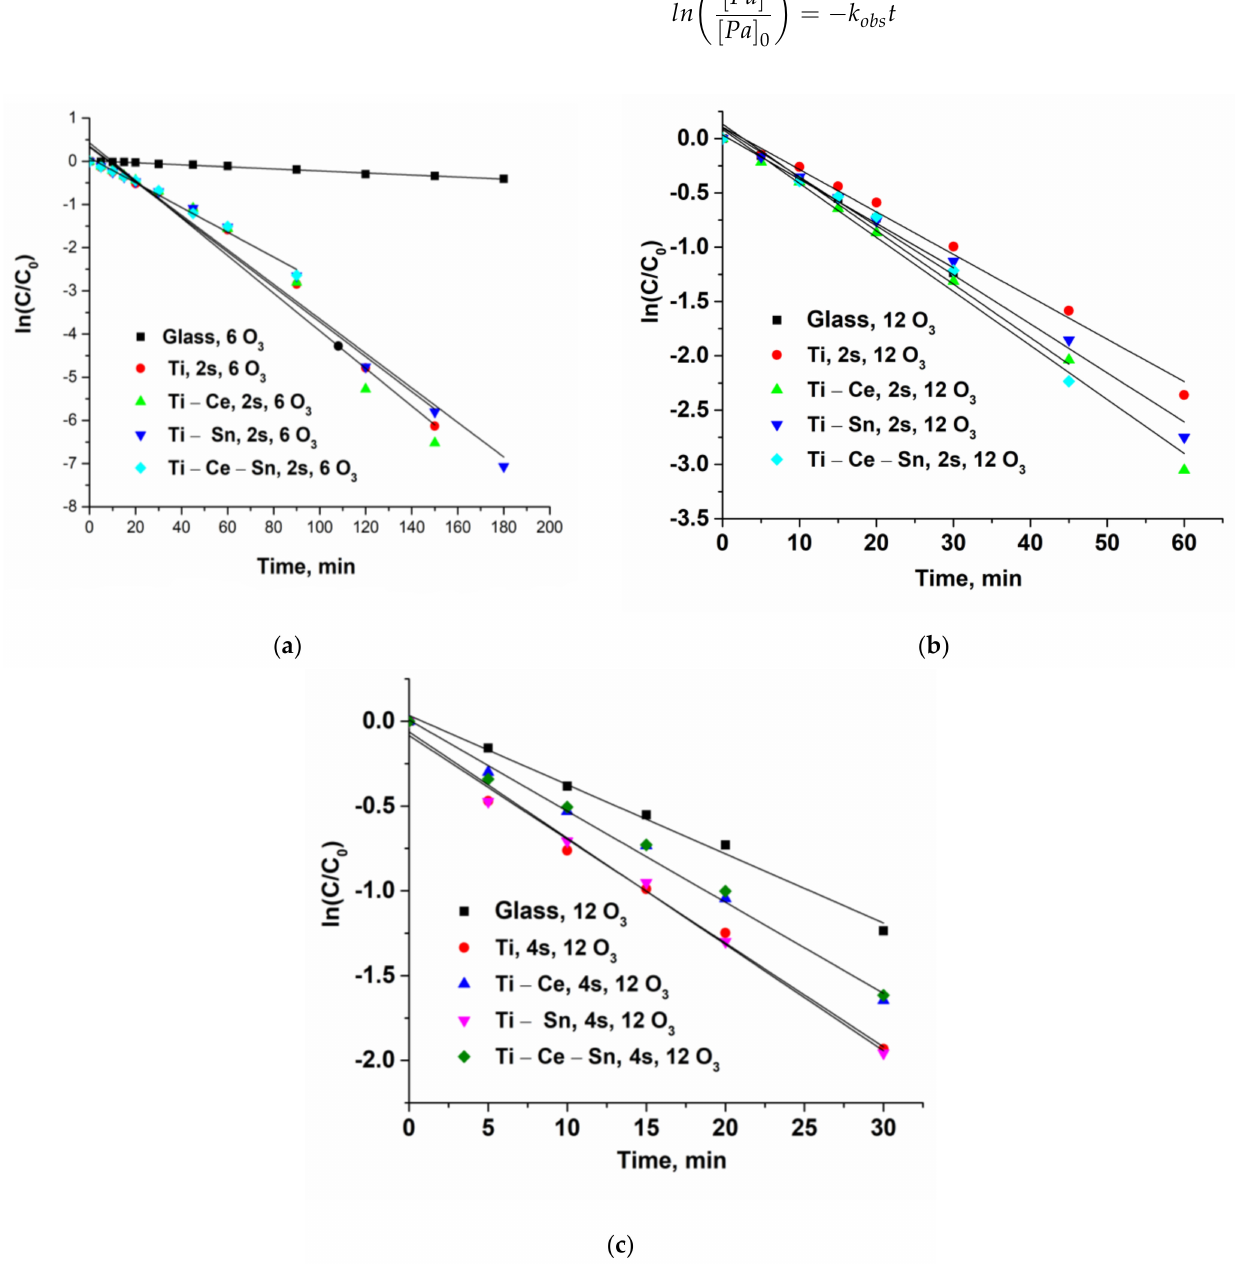
Figure 13. ( a ) Pseudo-first-order plots of ln(C/C o ) lower ozone input and two slides; ( b ) Pseudo-first- order plots of ln(C/C o ) higher ozone input and two slides; ( c ) Pseudo-first-order plots of ln(C/C o ) higher ozone input and four